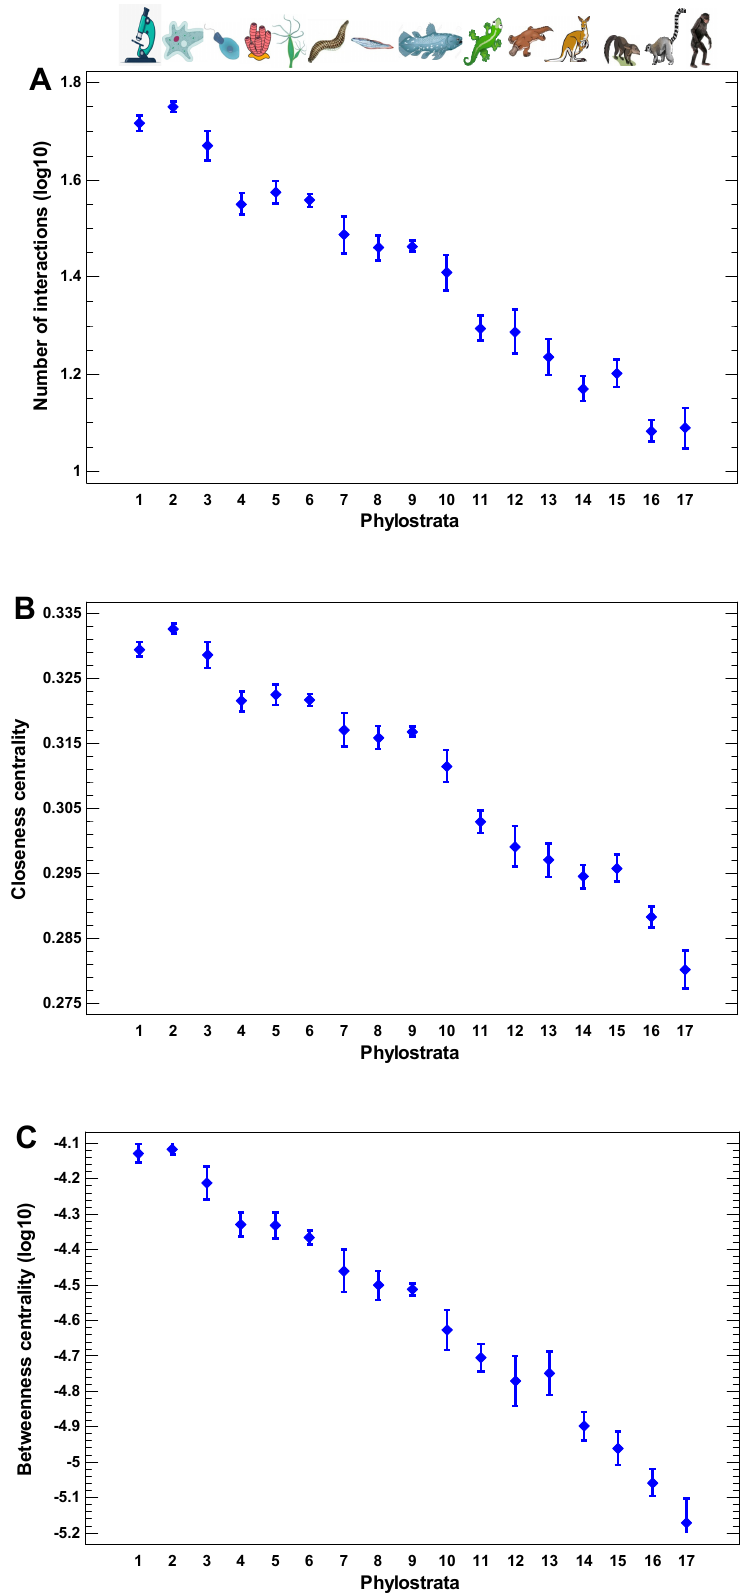
Figure 1. The evolutionary profile of local interaction density and global centrality measures in the human interactome. ( A ) The number of direct (one-step) interactions (degree). ( B ) Closeness (the reciprocal of the sum of the length of the shortest paths between a protein and all other proteins).